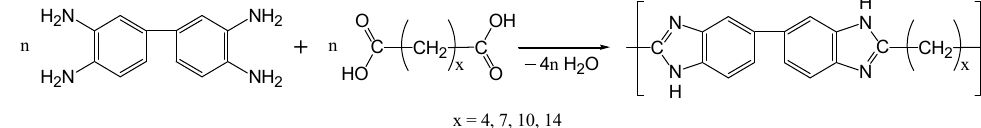
Figure 1. Scheme of the synthesis of aliphatic PBIs.